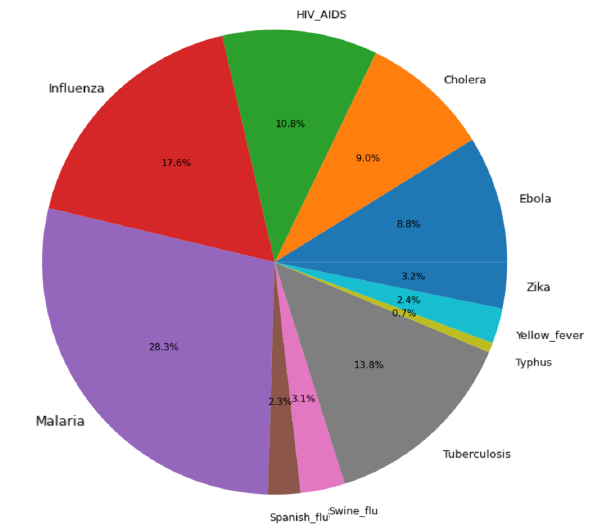
Figure 2. The composition of the 11